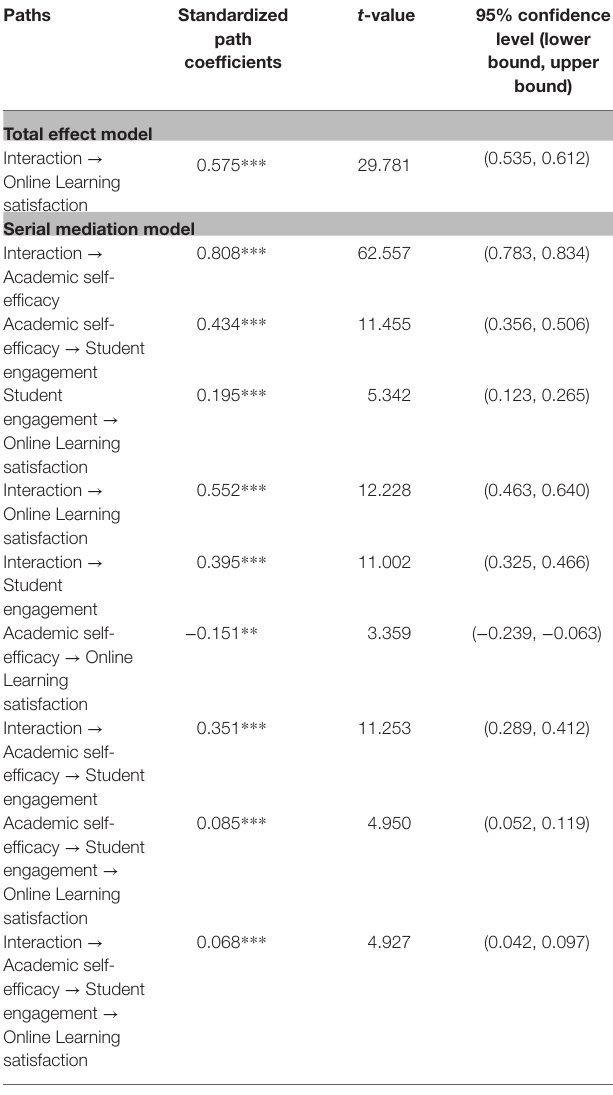
TABLE 3 | Structural model assessment.